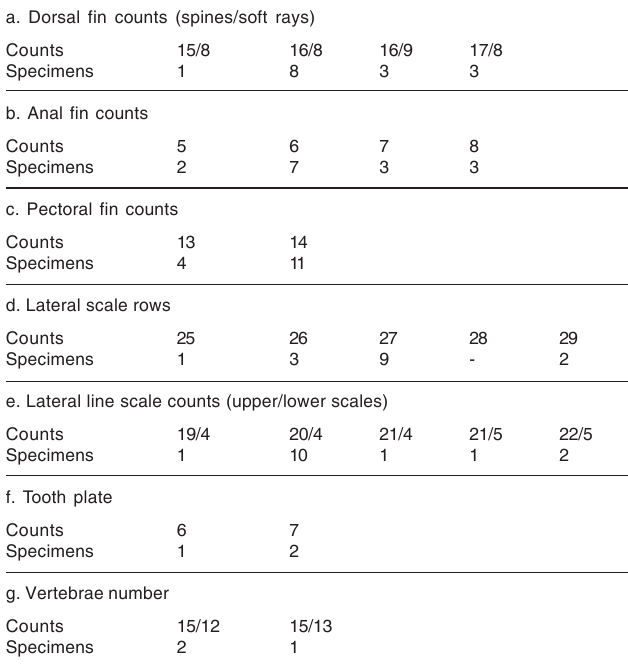
Table 2. Counts of Badis dibruensis sp. nov. In case of paratypes, maximum and minimum numbers are given.